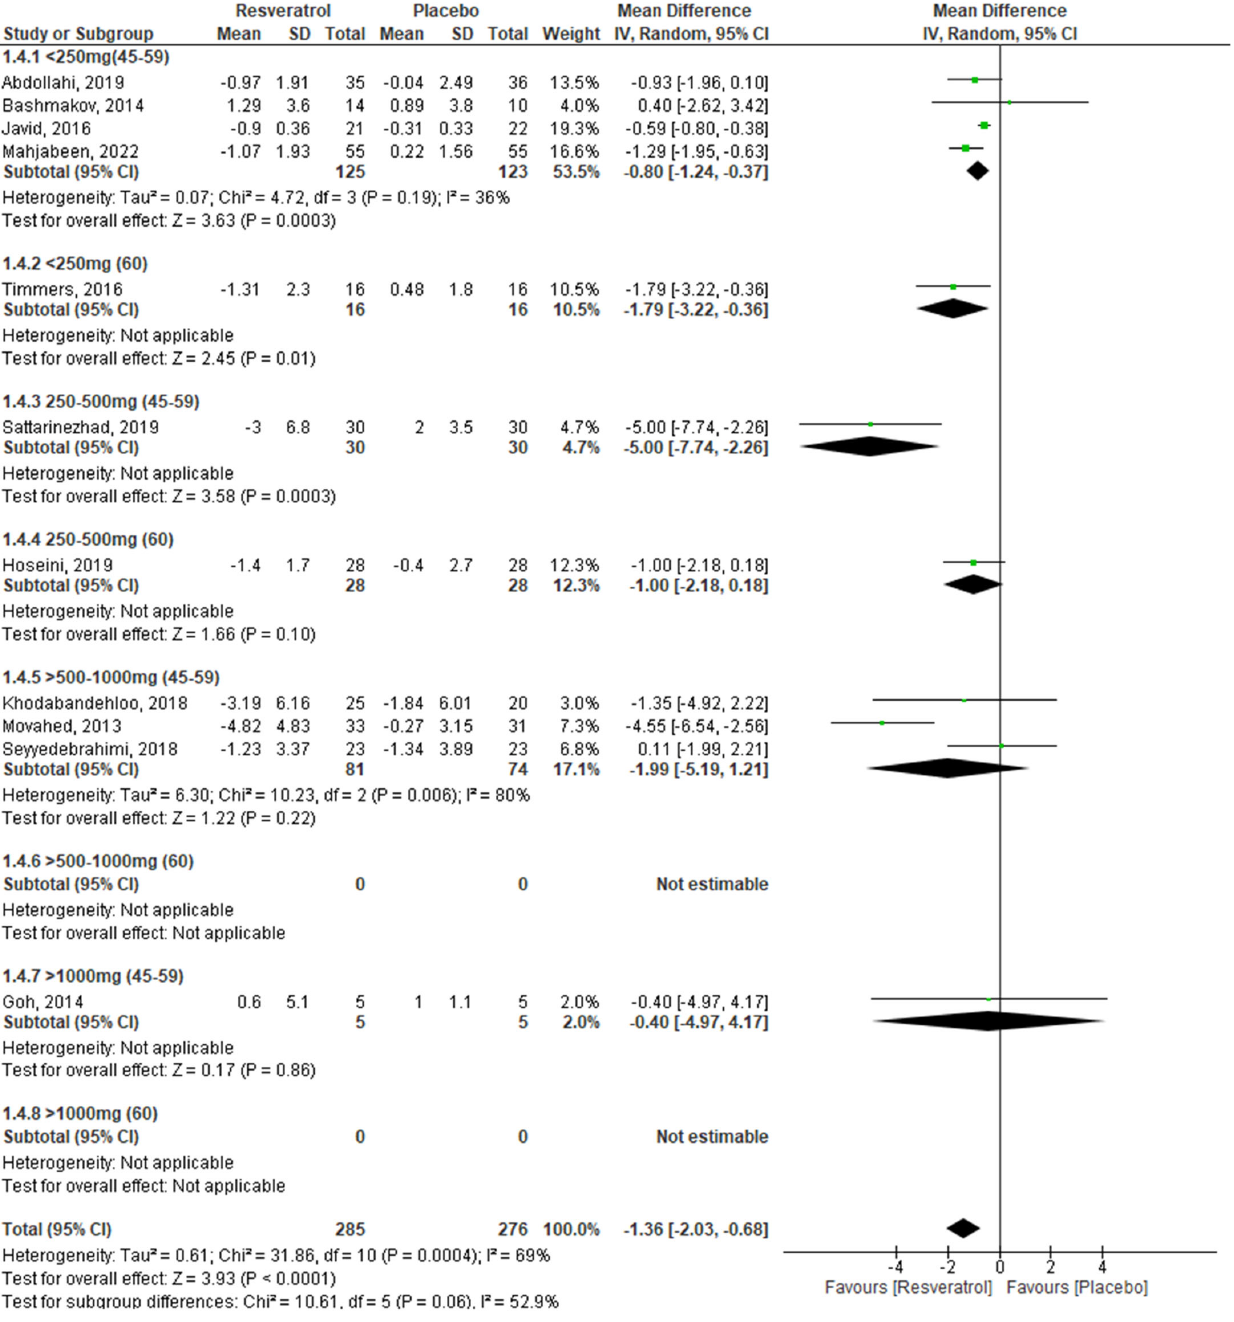
Figure 5. Effect of RV on insulin, stratified by age and dose.